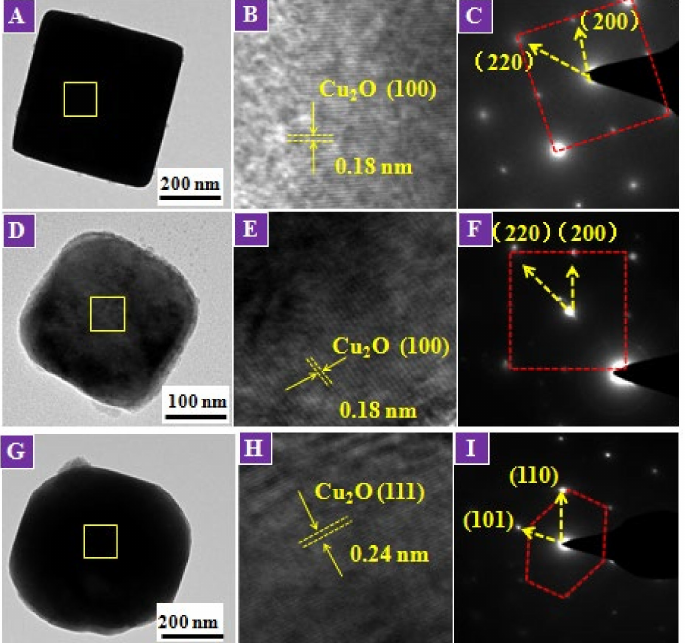
Figure 3. The detailed crystallographic features of the Cu 2 O nanocrystals. ( A , D , G ) the bright TEM images, ( B , E , H ) high-resolution TEM (HRTEM) image, ( C , F , I ) the corresponding SAED of c-Cu 2 O(100), Cu 2 O-1 and Cu 2 O-4(111), respectively. The yellow square border in ( A , D , G ) represents the selected area on the sample to be enlarged for